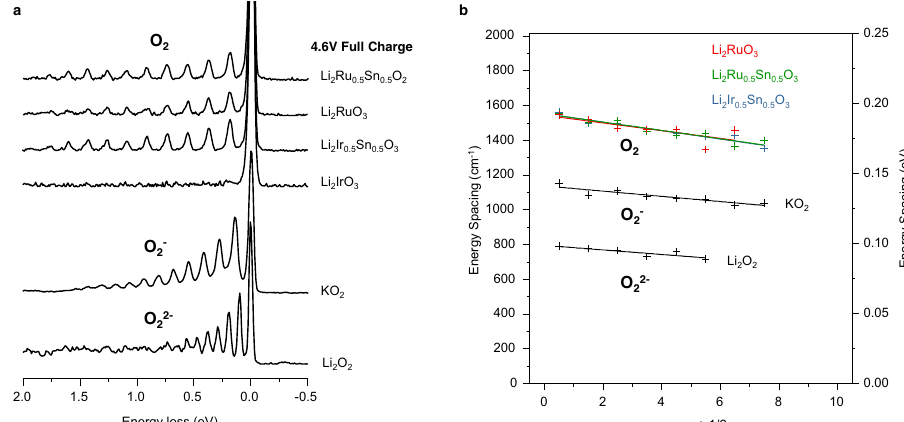
Fig. 4 Direct spectroscopic evidence against peroxides in charged 4d and 5d cathodes. a High resolution RIXS scans at 531 eV excitation energy for charged cathode samples and a Li 2 O 2 reference collected under identical measurement conditions. KO 2 RIXS was collected at 529.6 eV, where O 2 − vibrations are strongest. Peak spacing consistent with molecular O 2 is seen in the case of all cathodes except Li 2 IrO 3 which is not O-redox active. There is no evidence of O 2 2 − or O 2 − vibrations in any of the cathode samples ruling out the presence of peroxides and superoxides. b Birge-sponer plot showing linearly decreasing dependence of peak spacing with vibrational quantum number, n , consistent with the anharmonic oscillations of diatomic